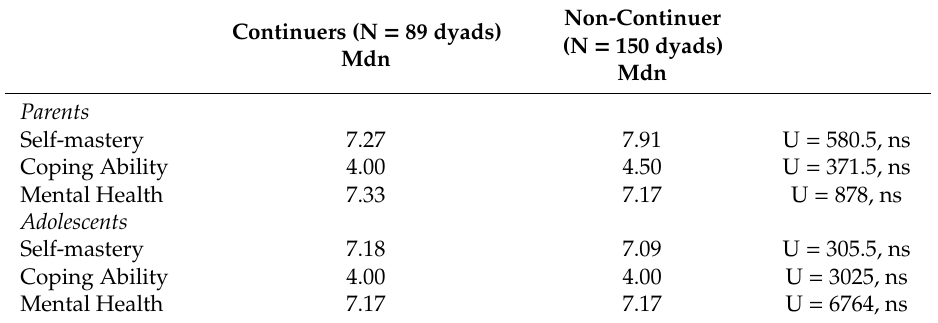
Table 1. Medians of the main variables and comparisons between continuers and non-continuers. Continuers (N = 89 dyads)